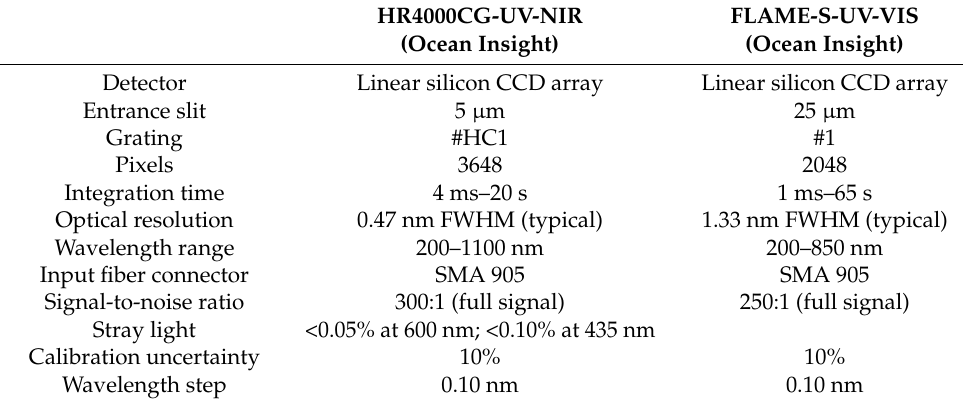
Table 1. Comparison of specifications of spectrometers used [35].